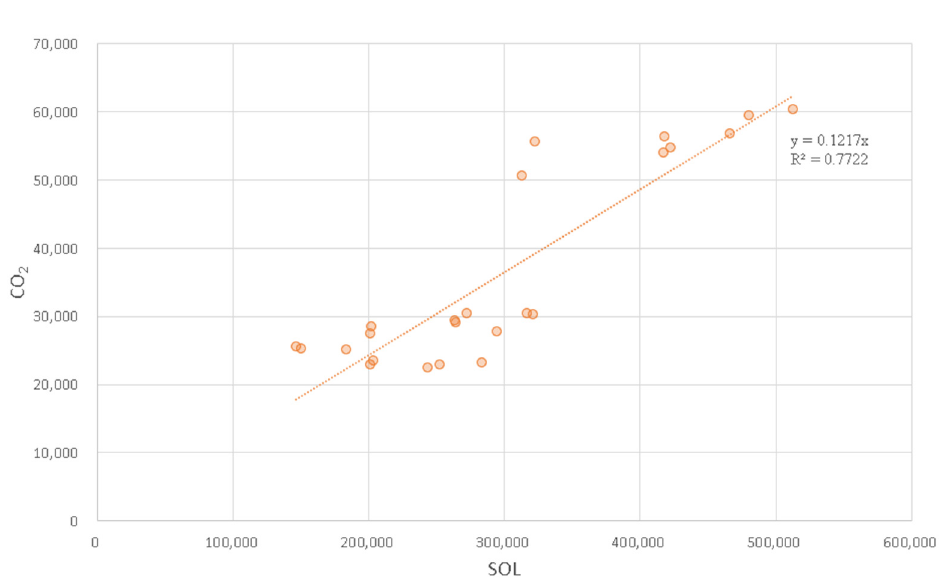
Figure 3. The fitting diagram of county CO 2 and county SOL in Northeast China from 2012 to 2020.